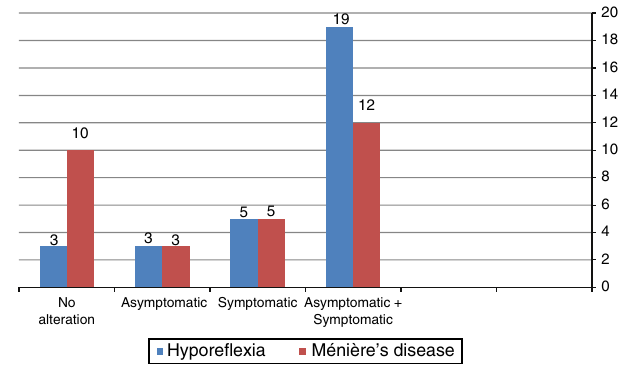
Figure 1 Frequency distribution of the outcome of combined cervical and ocular VEMP, per the affected side, for individuals with vestibular hyporeflexia and for individuals with Ménière’s disease ( n =